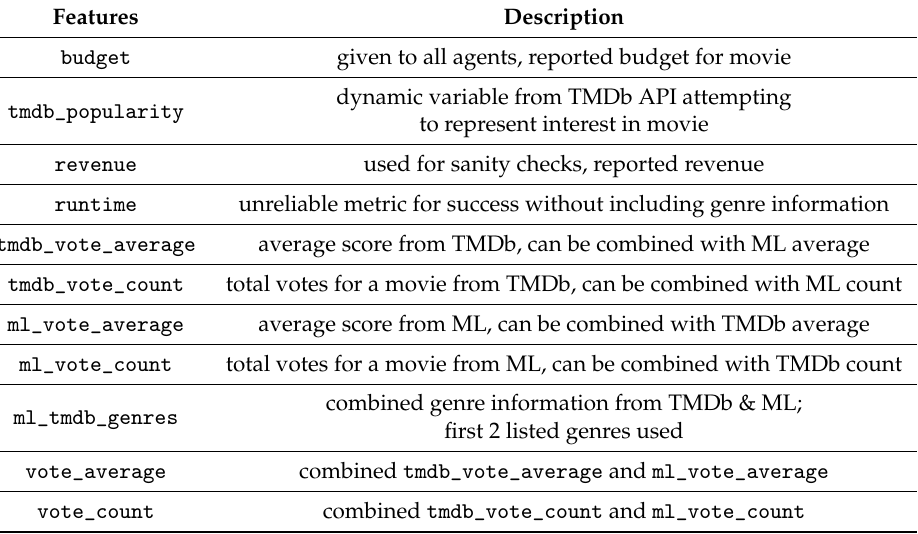
Table 1. Features available for